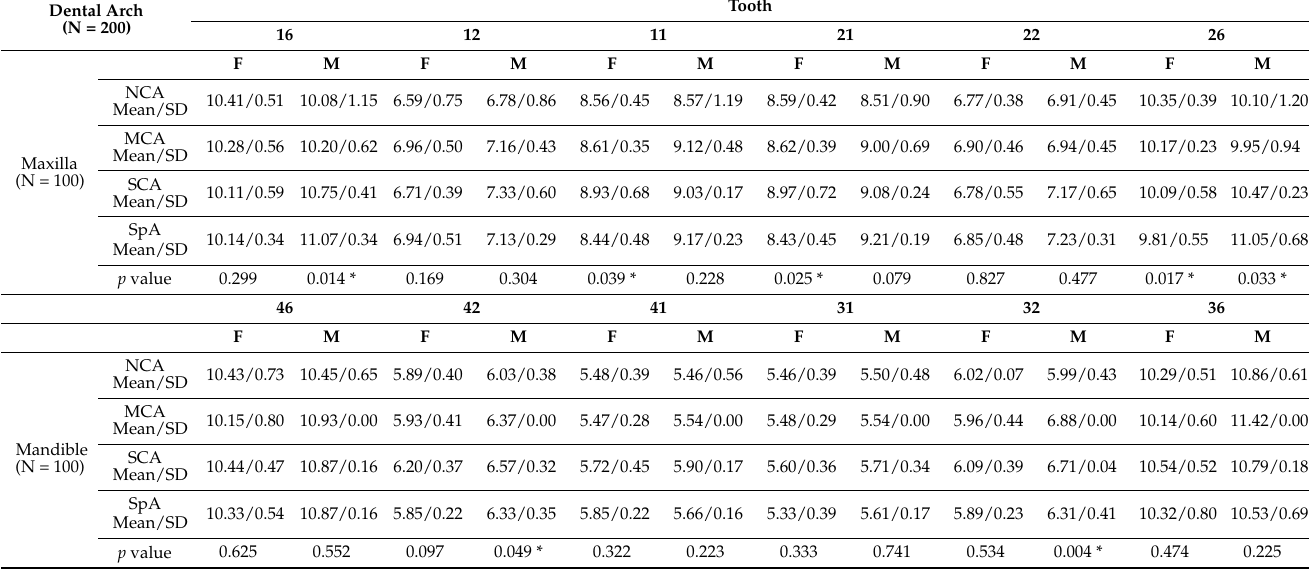
Table 5. Mesio-distal dimensions (mm) of permanent incisors and first permanent molars for female and male patients in the four groups (statistical significance according to ANOVA analysis).